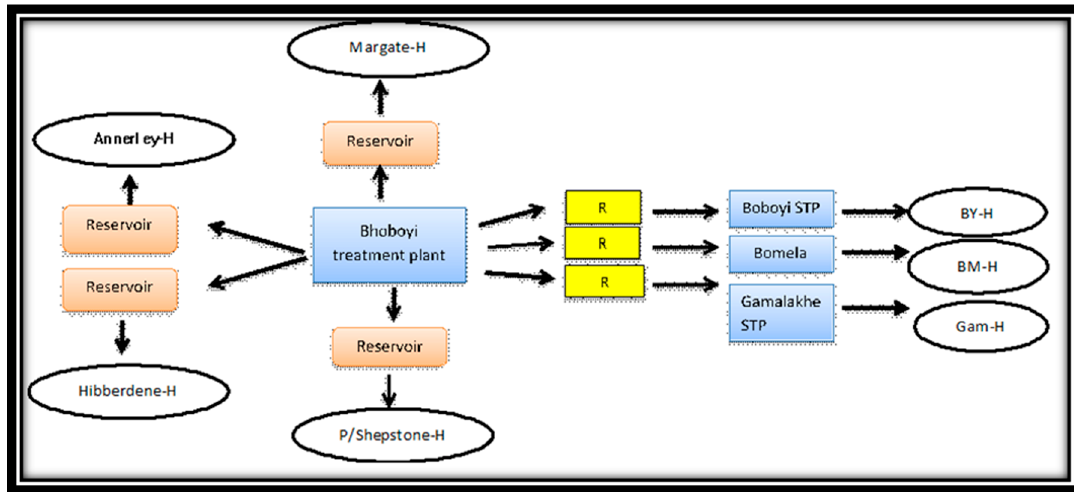
Figure 6. Mode of access to municipal drinking water supply in target urban and rural areas (H: house; R: reservoir; STP: Standpipe; BY-H: Boboyi house; BM-H: Bomela house; Gam-H: Gamalakhe house).